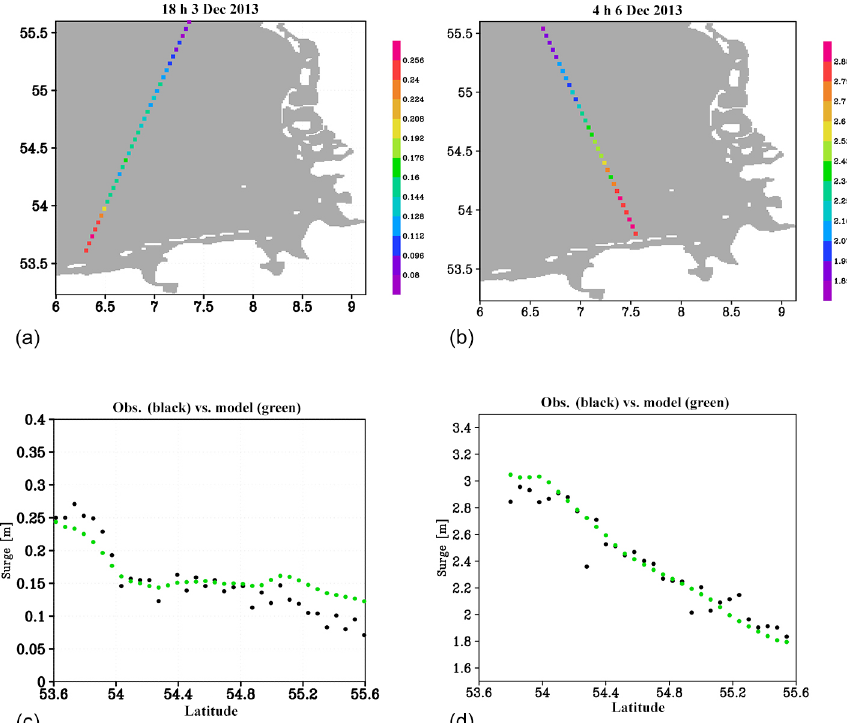
Figure 8. (a) Surge at the time of the SARAL overflight in calm conditions on 3 December 2013 at 18:00UTC, (b) same as (a) but during storm Xaver on 6 December 2013 at 04:00UTC, (c) profiles of SARAL/AltiKa overflight of surge height derived from altimeter observations (black circles) and from GETM model (green circles) on 3 December 2013 at 18:00UTC, (d) profiles of SARAL/AltiKa overflight of surge height derived from altimeter observations (green circles) and from GETM model (yellow circles) on 6 December 2013 at 04:00UTC.